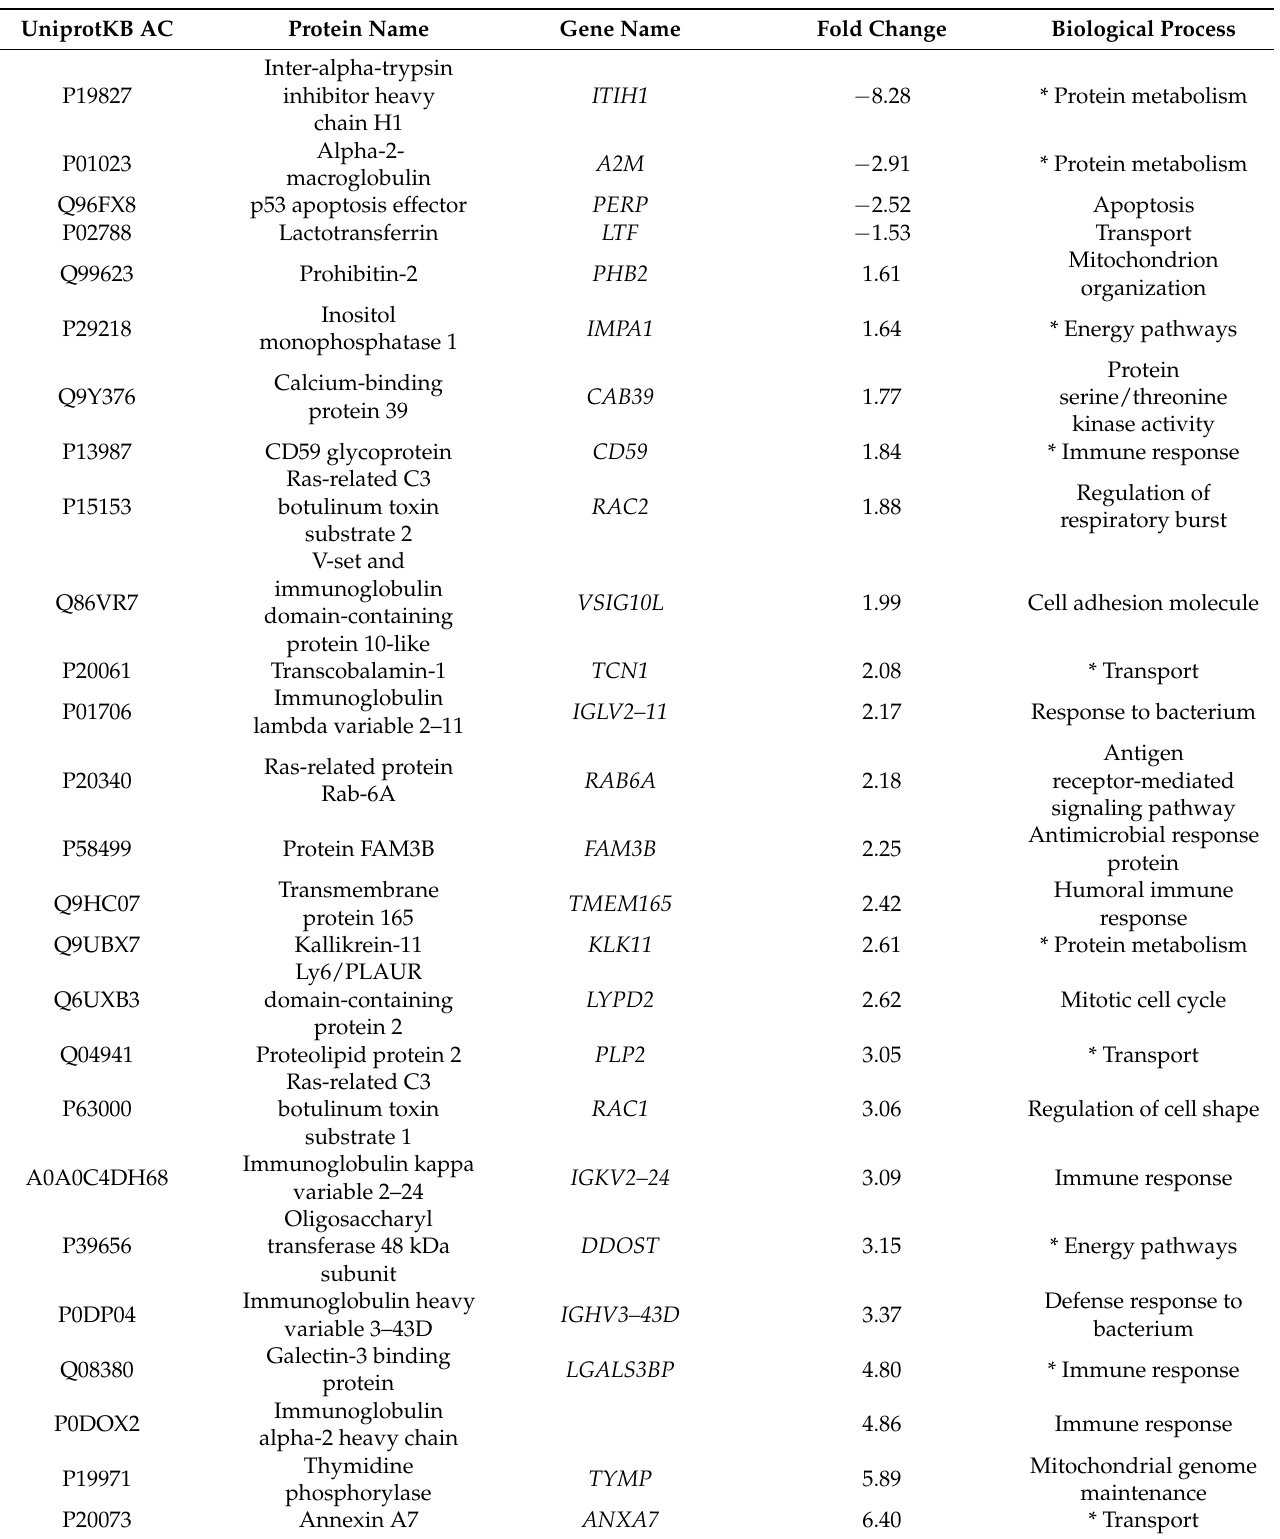
Table 1. List of the proteins with a VIP score > 1. These are the proteins that better differentiate COVID+ and COVID- samples. Shown are the UniprotKB AC code, protein names, gene names, fold change (COVID+/COVID-) and the biological process defined by the enrichment analysis. * Proteins involved in enriched biological